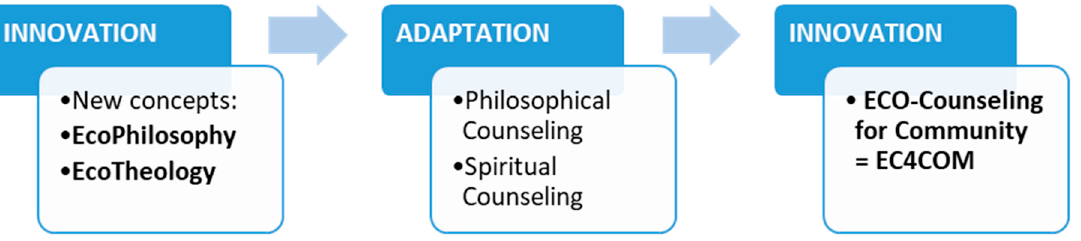
Figure 8. Evolution toward innovation and adaptation of the analyzed